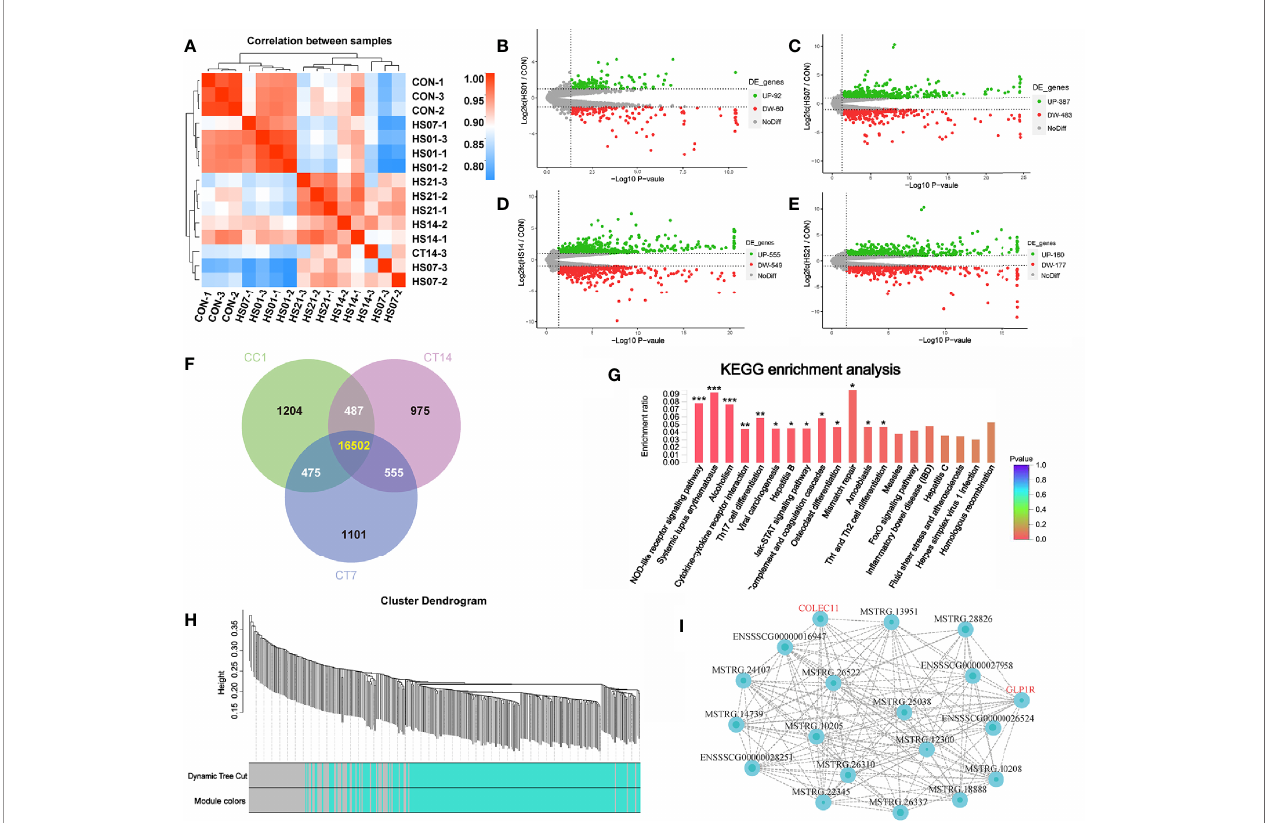
FIGURE 10 | TranscriptionsequencinganalysisofHS pigcolon.CONindicatesnoheat stressgroupofday1,HS1, 7,14, 21indicateheatstressday1, 7, 14, and21groups, respectively,n=3. “ * ” meansp<0.05, “ ** ” means p<0.01, “ *** ” means p<0.001; (A) distanceheatmapbetweensamples; (B-E) expressiondifferencevolcanoplots. (F) Venn analysisbetweengroups, (G) difference geneKEGG enrichmentanalysis; (H) WGCNA modularanalysis; (I) WGCNA